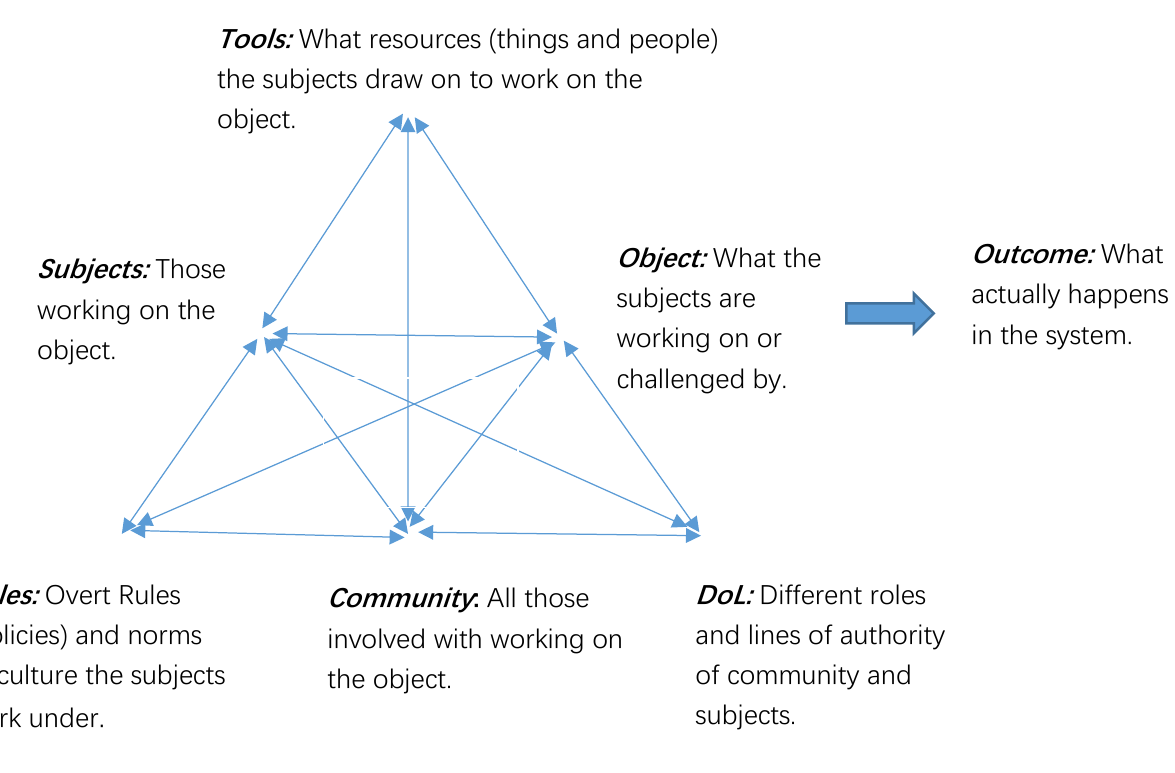
Figure 1 : An activity system as the unit of study (After Virkkunen & Newnham, 2013: 34) Expansive